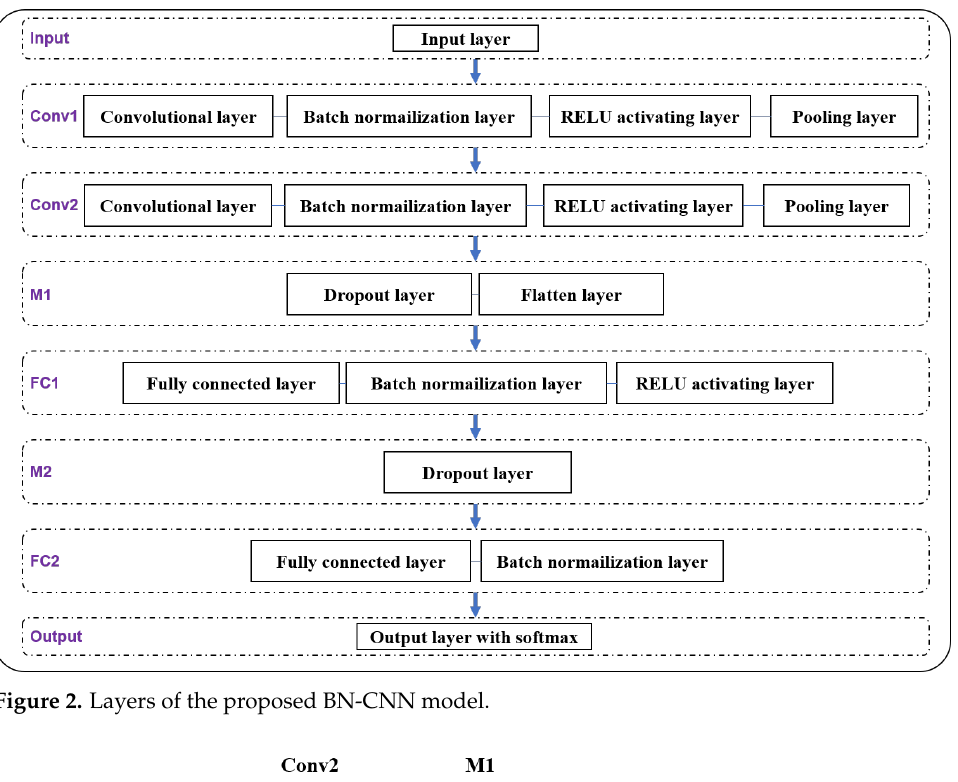
Figure 2. Layers of the proposed BN-CNN model.